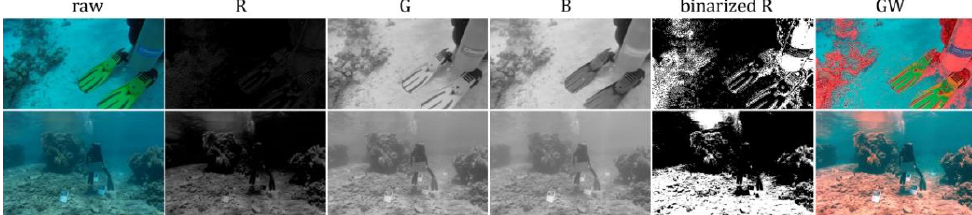
Figure 13. Reddish artifacts produced by conventional color correction method. From left to right are raw underwater images, R channels, G channels, B channels, binarized R channels and the results of gray-world (GW) method.